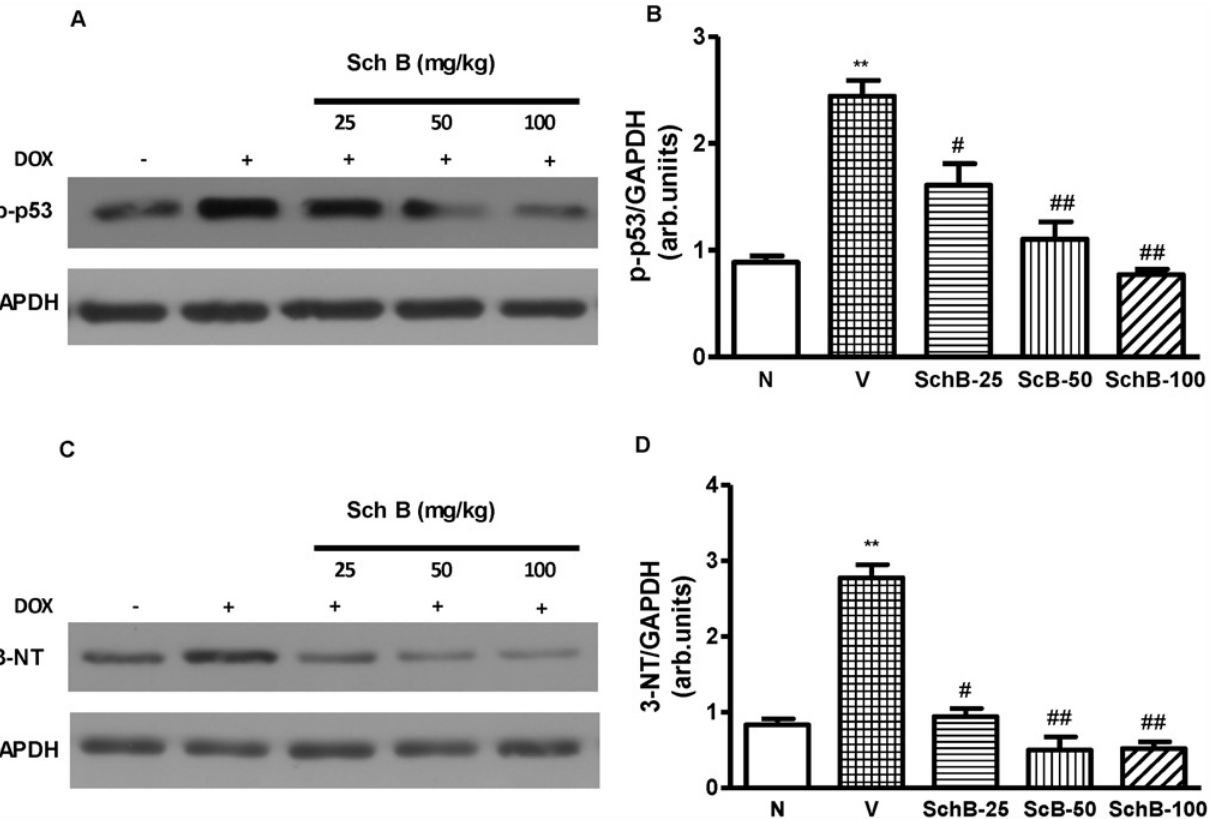
Fig 4. Sch B attenuated LV p-53 and 3-NT expression. (A – D) Representative Western immunoblots and densitometry analysis using Scion image software for p-p53 (A, B), and 3-NT (C and D), normalized against GAPDH. Each bar represents means ± S.E. (n = 4 – 5). ** P < 0.01 vs. group N mice; # P < 0.05 and ## P < 0.01 vs. group V mice.